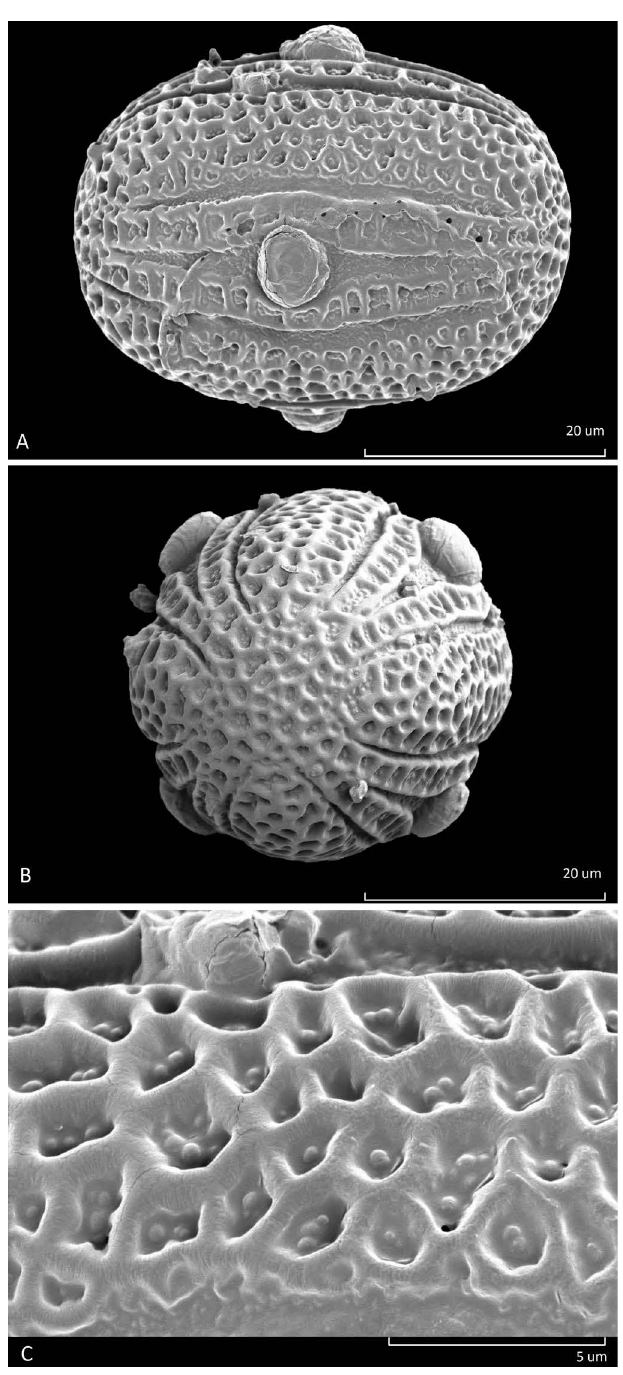
Figure 3 – SEM images of J. gigantophylla pollen. A . Apertural view. B . Polar view. C . Detail of interapertural exine. Material used: Cheek 17553